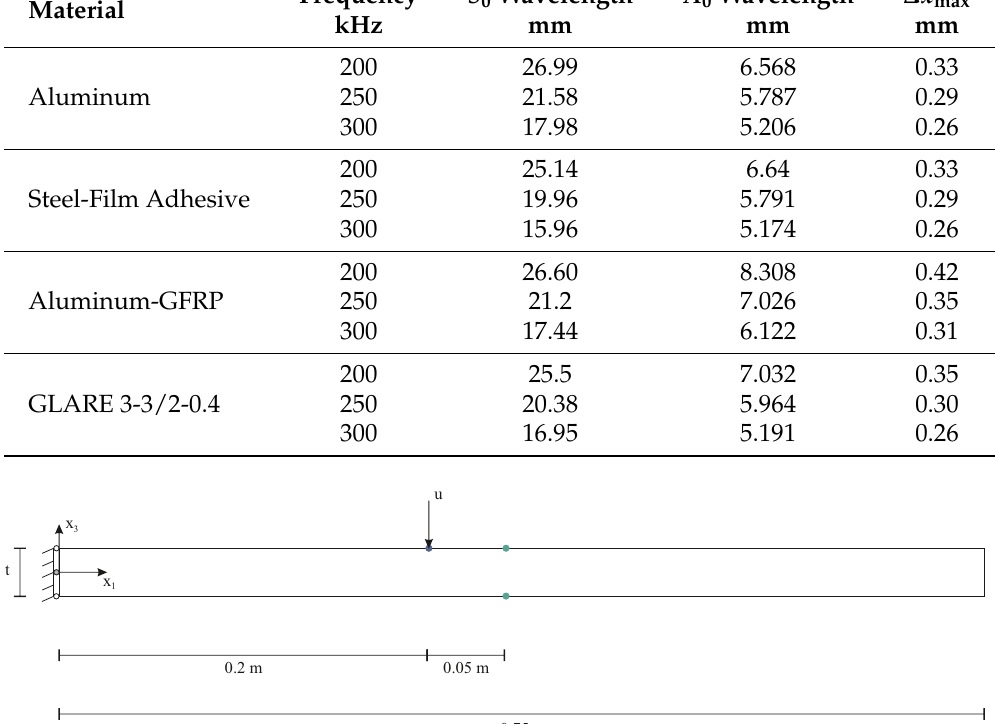
Figure 2. Graphical representation of the numerical model and its boundary conditions as described in Section